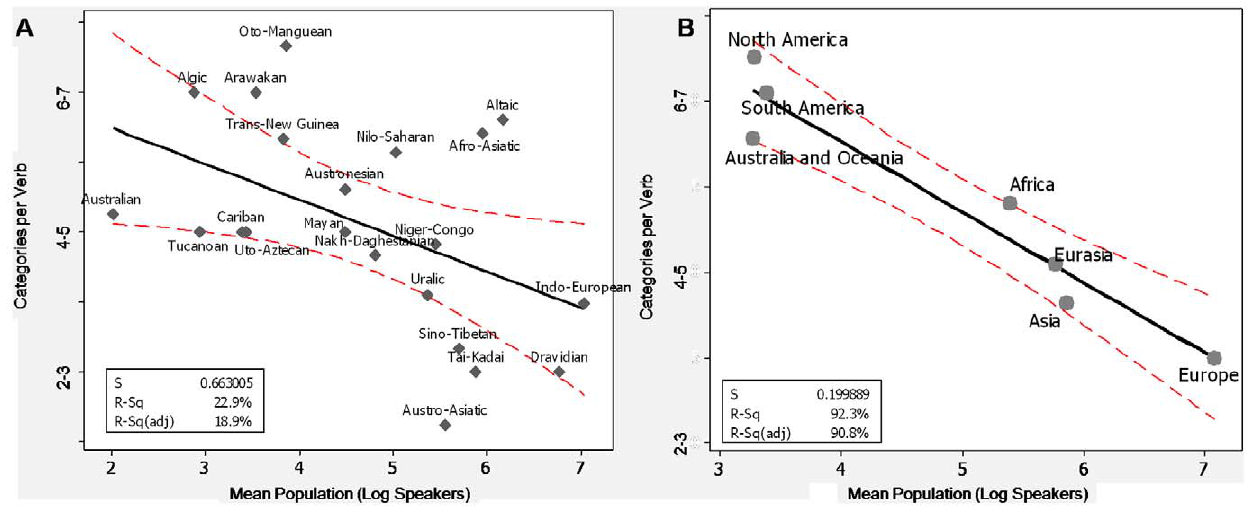
Figure 4. Complexity of verb morphology by language family and geographic regions. (A) Inflectional synthesis of the verb (feature 6 in Table 1) plotted against the mean number of speakers for the largest language families (those containing $ 32 languages). (B) Inflectional synthesis of the verb collapsed by continent. Each point plots the average feature value for the language family. The regression line is flanked by 95% CIs. Eurasia corresponds to the region 38 u N–71 u N/29 u E–172 u